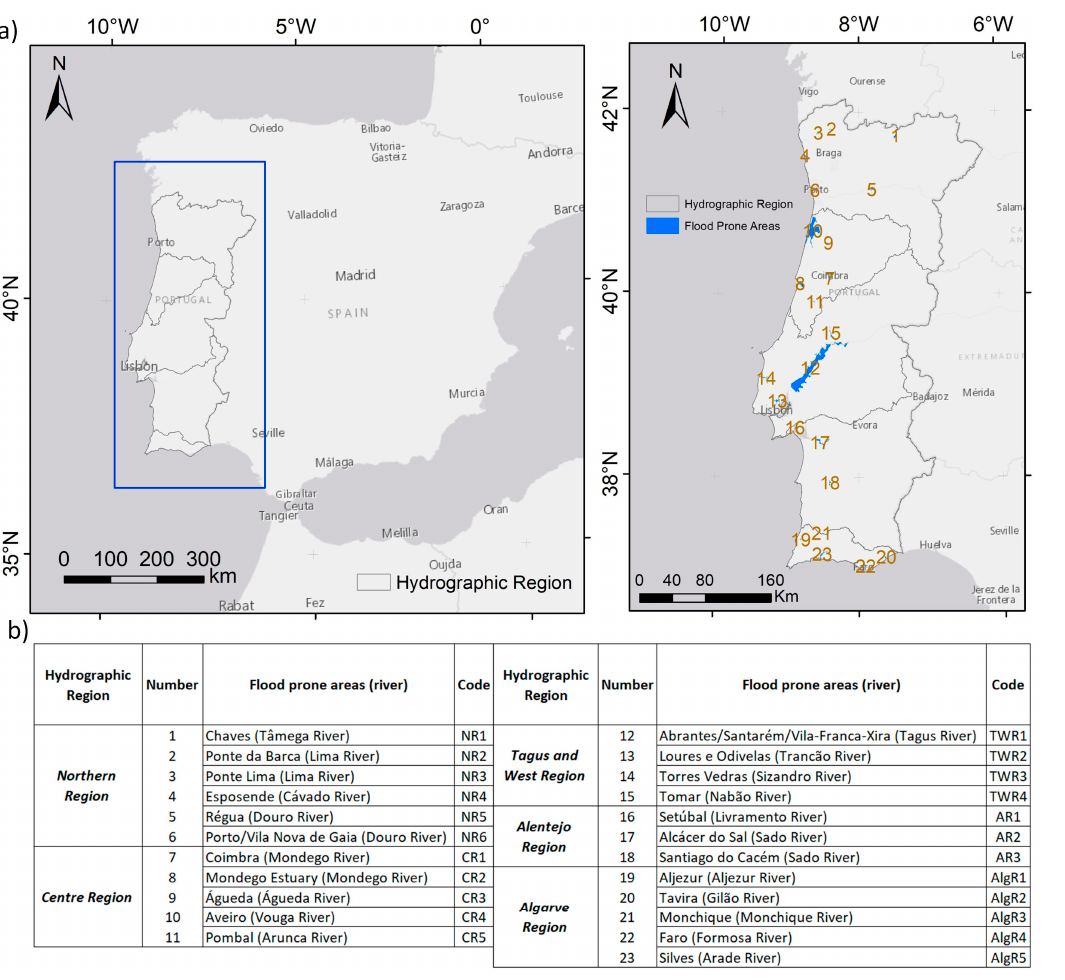
Figure 1. ( a ) Flood-prone area’s location; ( b ) Portuguese Hydrographic Regions and flood-prone areas